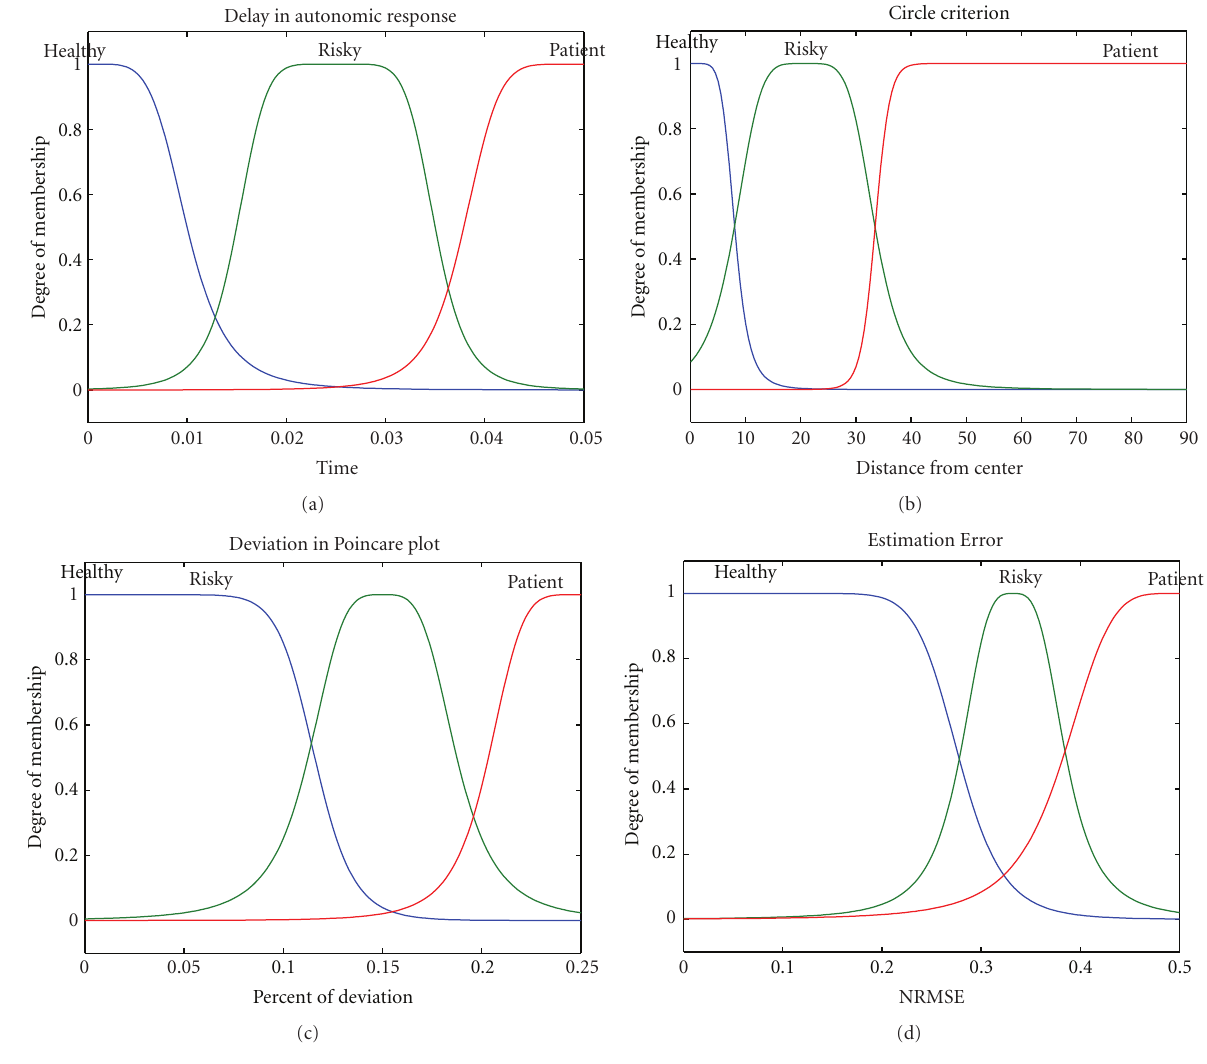
Figure 6: The designed membership functions for each criterion.